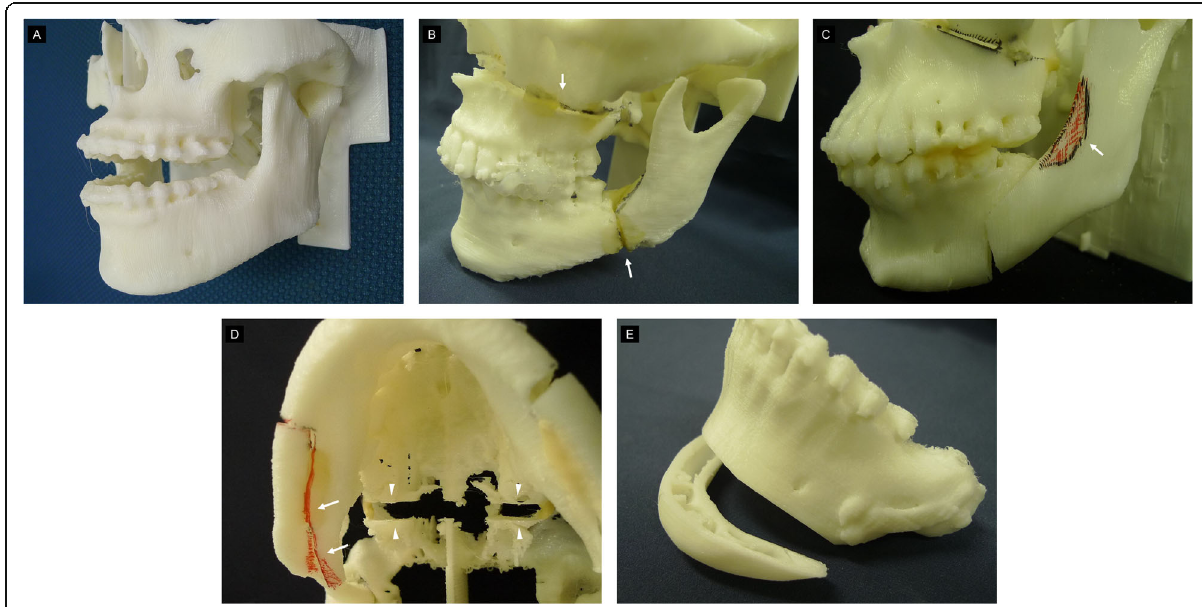
Fig. 6 3D models used for orthognathic surgery, fabricated with a desktop 3D printer and surgical simulation. Since the FOV is from the orbital floor to the lower edge of the mandible, the slice thickness is greater. Therefore, the reproducibility of the morphology of the teeth is poor, but the accuracy is sufficiently high for osteotomy simulation. a 3D model with maxillary retrusion and mandibular protrusion. b Surgical simulation of Le Fort I osteotomy and SSRO (arrow). c By performing 3D model surgery, the amount of trimming of the anterior mandibular ramus can be predicted (arrowheads). d The arrowhead shows the amount of maxilla movement. The arrow shows bone interference. e In genioplasty, checking the width and height of bones and the position of mental foramen with a 3D model is very useful for predicting risk